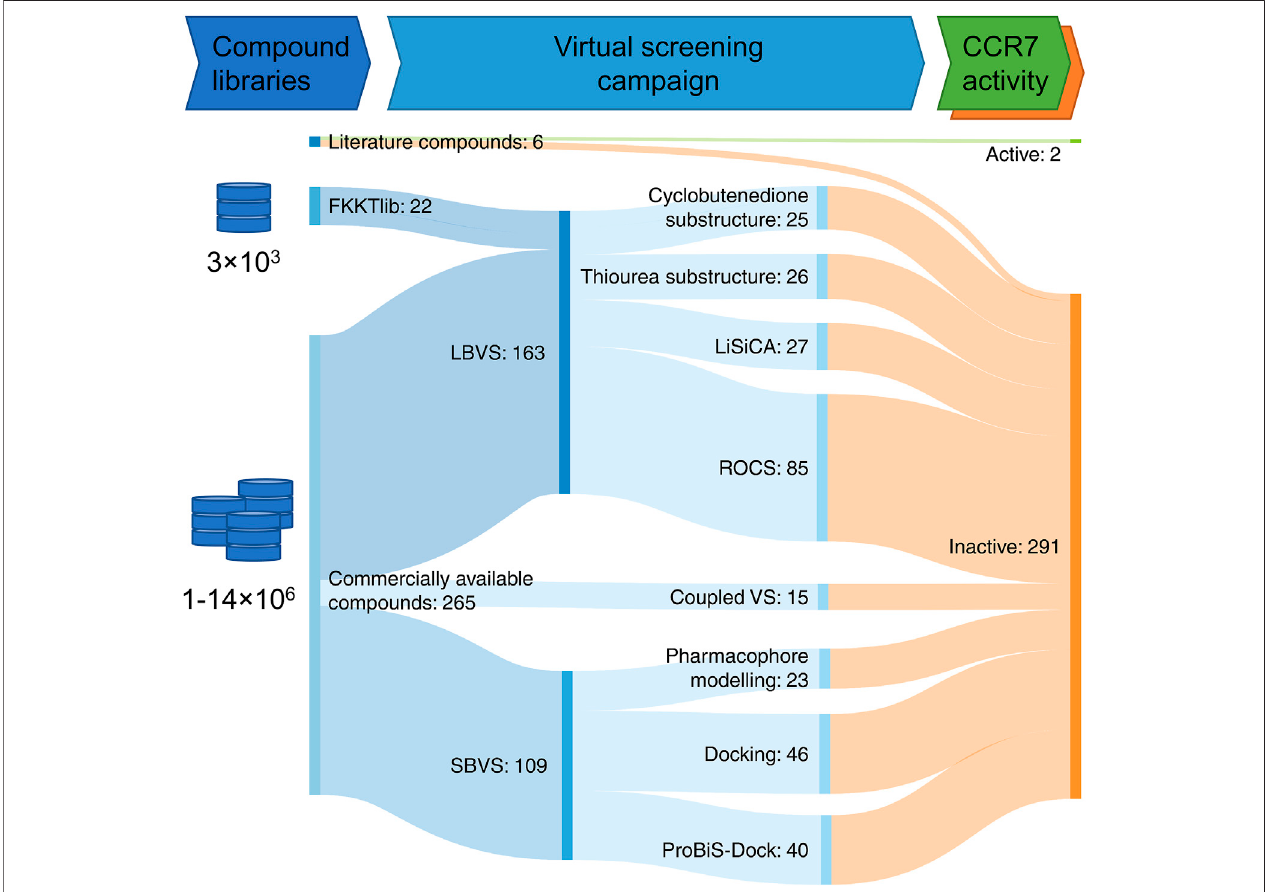
FIGURE4| Virtualscreeningwork fl owrepresented asaSankey diagram.Compoundsdescribedinthismanuscriptwereobtainedfromthescienti fi cliterature,the FKKTlib academic library, and databases of commercially available compounds. Different ligand-based virtual screening (LBVS) (core motif substructure search, screening with LiSiCA and ROCS software), structure-based virtual screening (SBVS) (pharmacophore screening and docking) and coupled virtual screening (VS.) approaches were explored. Altogether 293 compounds were tested in the CCL19 induced calcium signaling CCR7 assay.